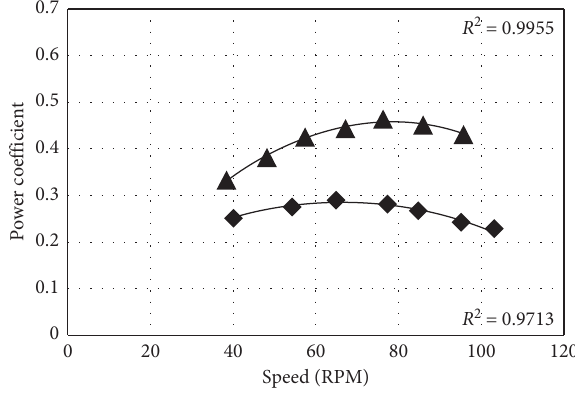
Figure 18: Runner 1 data points.